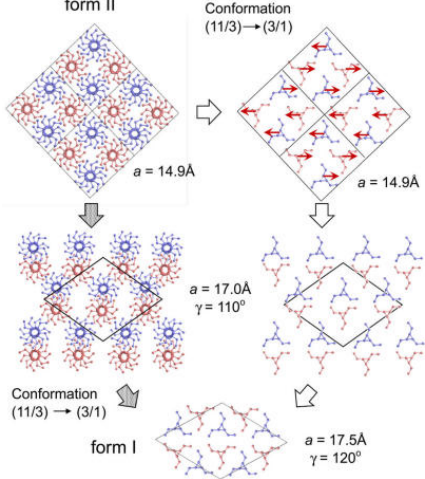
Figure 26. Schematic representation showing the possible chain conformation change of iPBu during form II to form I transformation. Reproduced with permission from Ref. [23], copyright 2016 American Chemical Society.